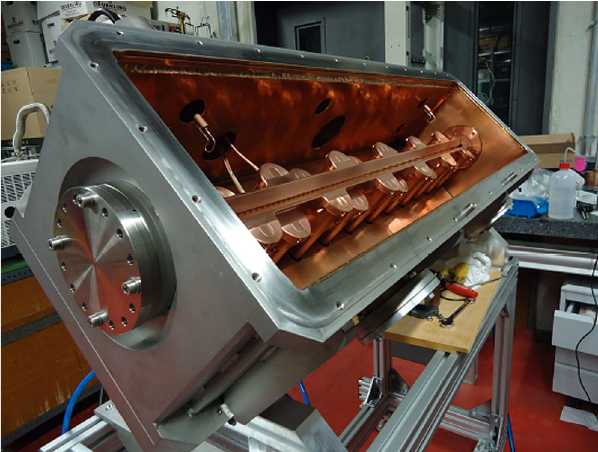
FIG. 4. The four-rod RFQ for FNAL during rf setup at IAP Frankfurt. This process includes adjustment of the resonant frequency and longitudinal voltage distribution, assembling of the piston tuner, matching of the coupling loop, as well as mechanical cross